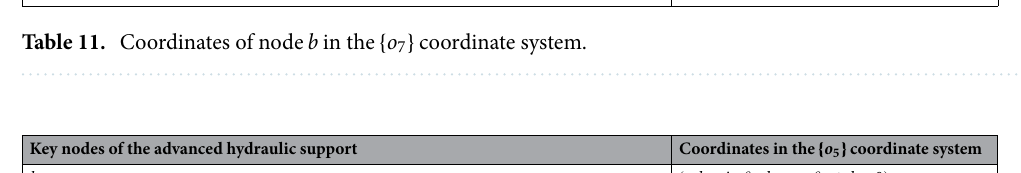
Key nodes of the advanced hydraulic support